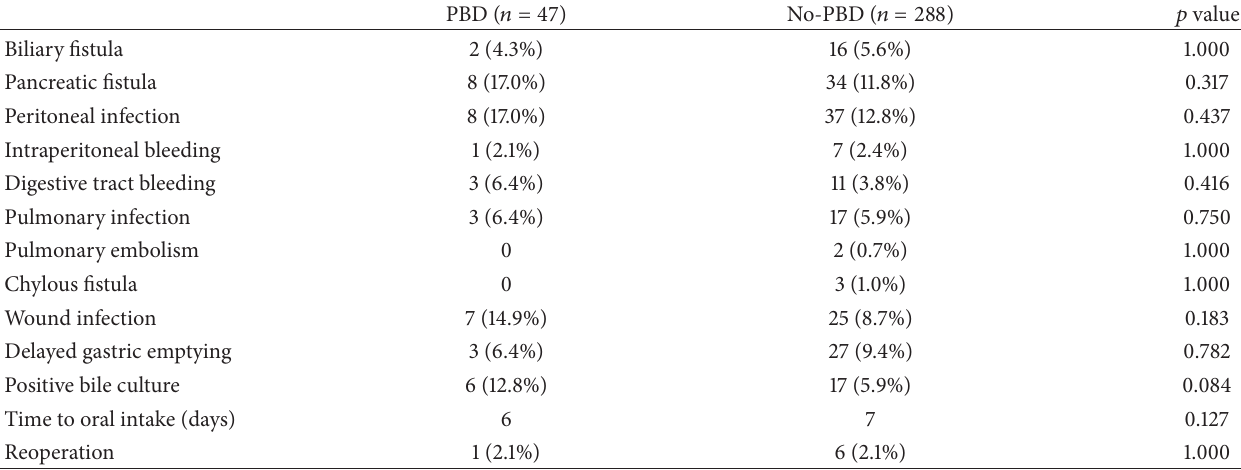
Table 2: Postoperative complications between the two groups.